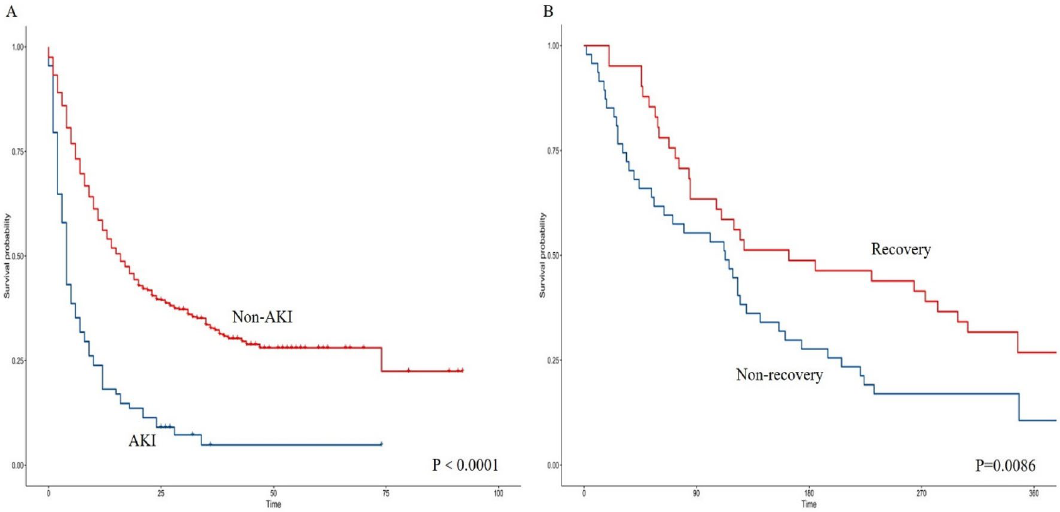
Figure 3. Survival analysis of AKI patients versus non-AKI patients. ( A ). Survival analysis of patients with restored renal function versus those with unrestored renal function. ( B ).